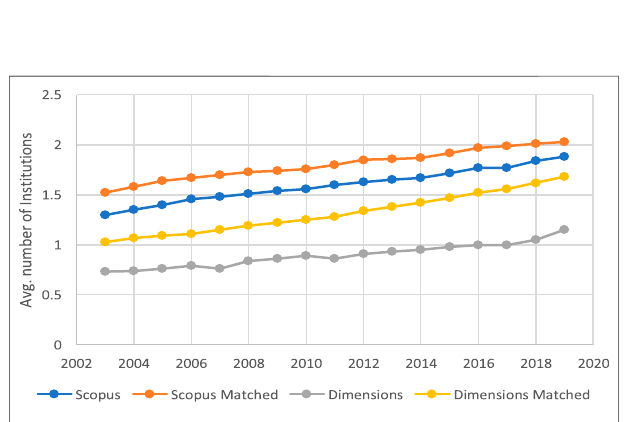
FIGURE 4 | Evolution of the average number of institutions per document in Scopus and Dimensions in total and in the matched subsets.